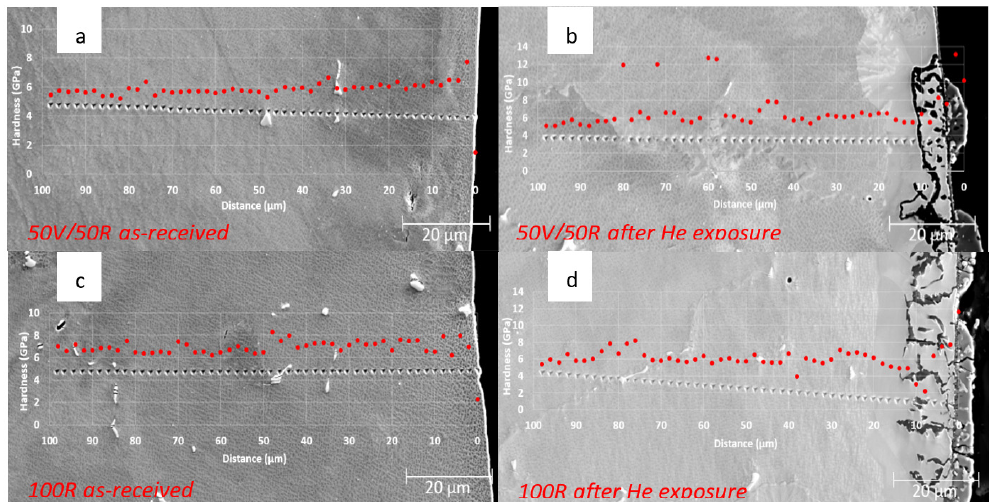
Figure 11. Nanoindentation performed in the cross-section: ( a ) as-received 50R; ( b ) 50R after He exposure; ( c ) as-received 100R; ( d ) 100R after He